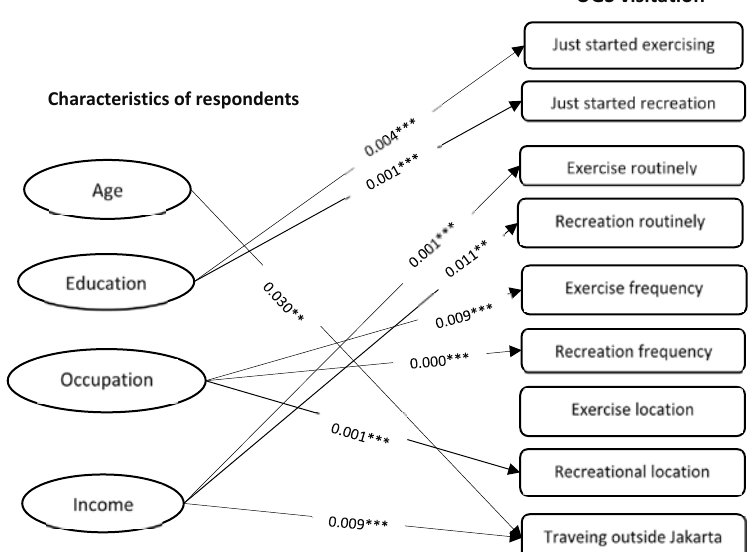
Fig. 4: The patterns of direct correlations between the characteristics of respondents and motivations for UGS visitation (** p < 0.05; *** p < 0.01)